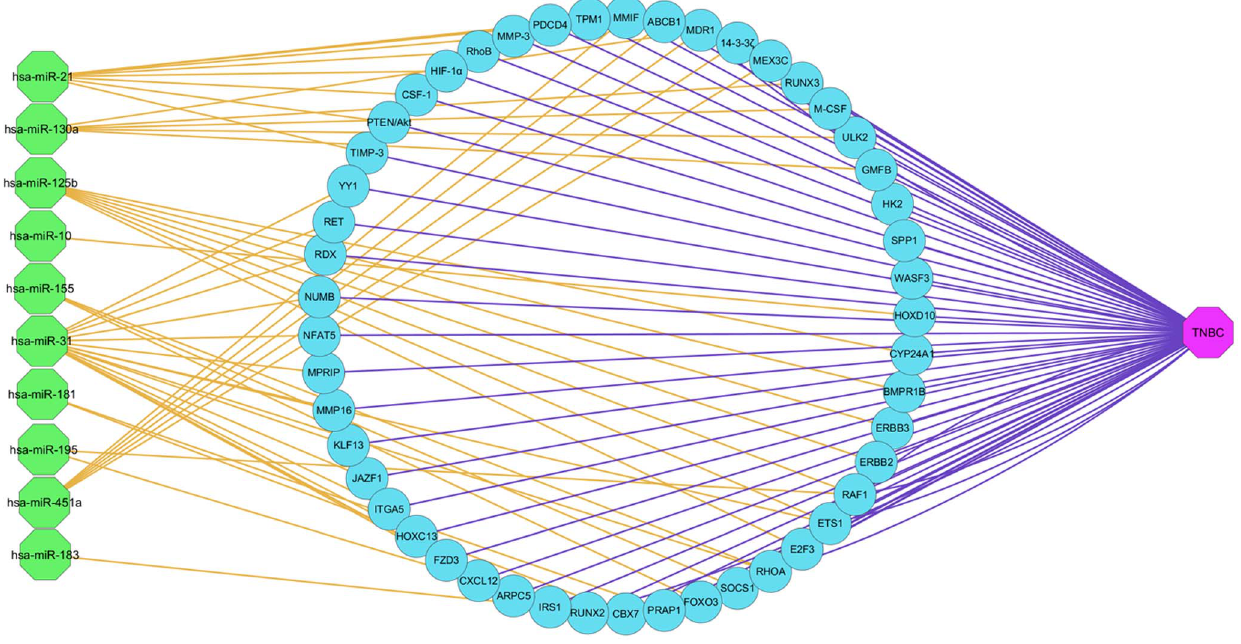
Figure 4. Network among the specific deregulated miRNAs and their predicted targets in this study.